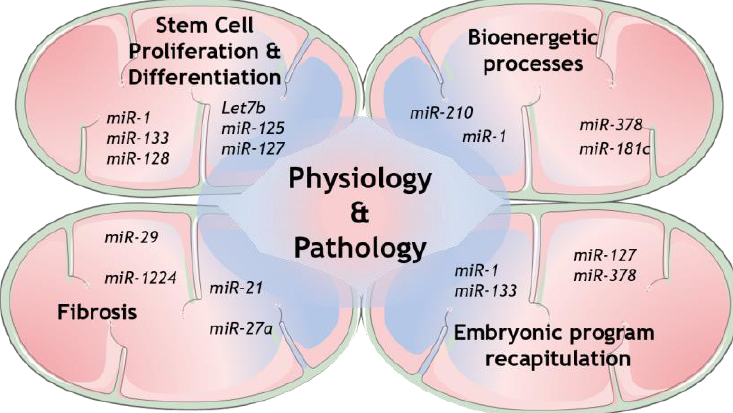
Figure 2. Modulation of physiologic and/or pathologic mechanisms by mitochondrial miRNAs. Several mechanisms that contribute to physiopathology require some biological functions that are modulated by different mitochondrial microRNAs.